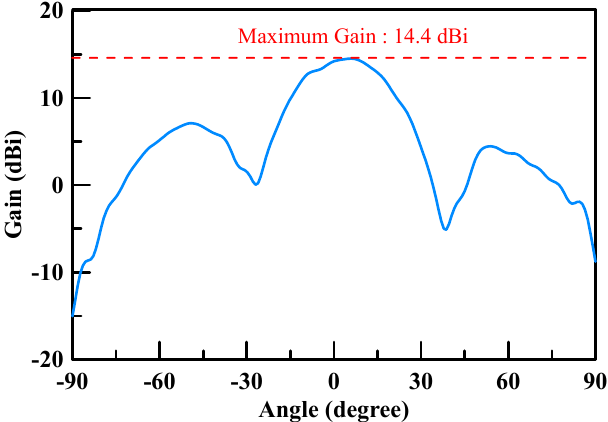
Figure 21. Array antenna (2 × 2) gain measurement results (phase 0 / 180 / 180 / 0, Y-cut).